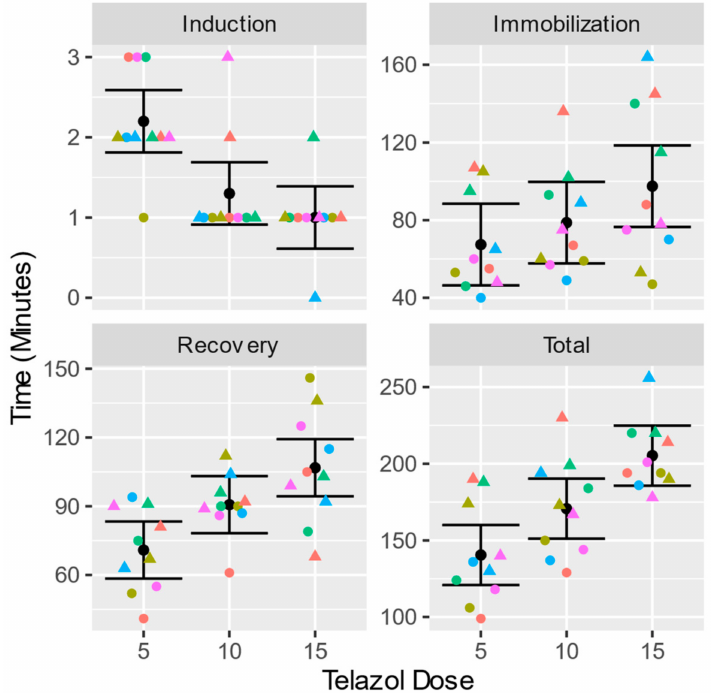
Figure 1. Induction, immobilization, recovery, and total times with three different doses of Telazol ® . The error bars show the marginal means and 95% confidence intervals. The individual times are plotted as circles for animals receiving 5, 10, and 15 mg/kg of Telazol ® and as triangles for animals receiving 15, 10 and 5 mg/kg. Individual animals are represented by the symbols’ shape and